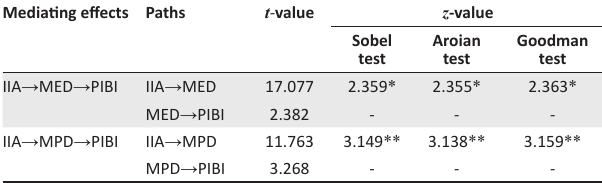
TABLE 6: Mediator analysis.